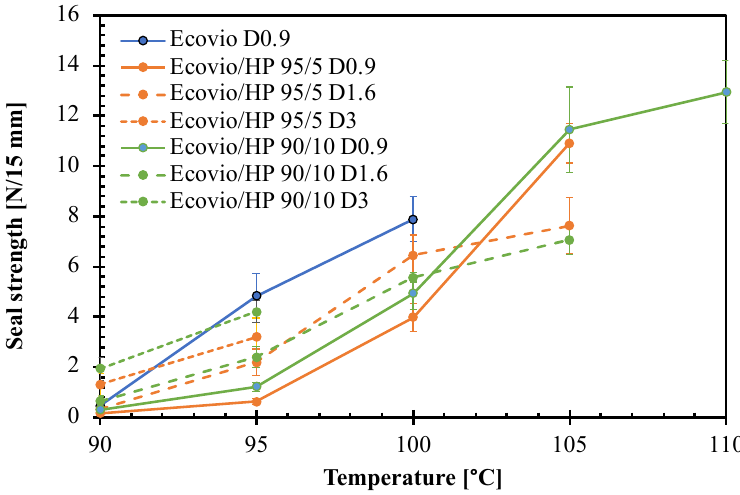
Figure 9. Effect of welding temperature on sealing strength of films with different average thickness and hazelnut perisperm loading.